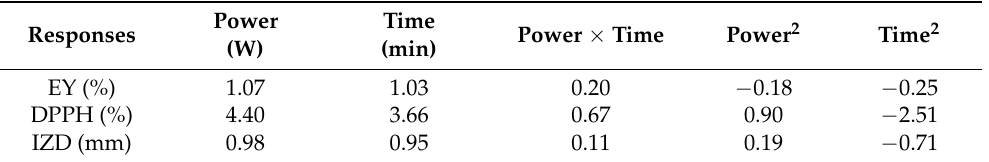
Table 1. The regression model coefficients for prediction of extraction yield (EY), antimicrobial activity (IZD), and antioxidant activity (DPPH) during SBL extraction at various process conditions.